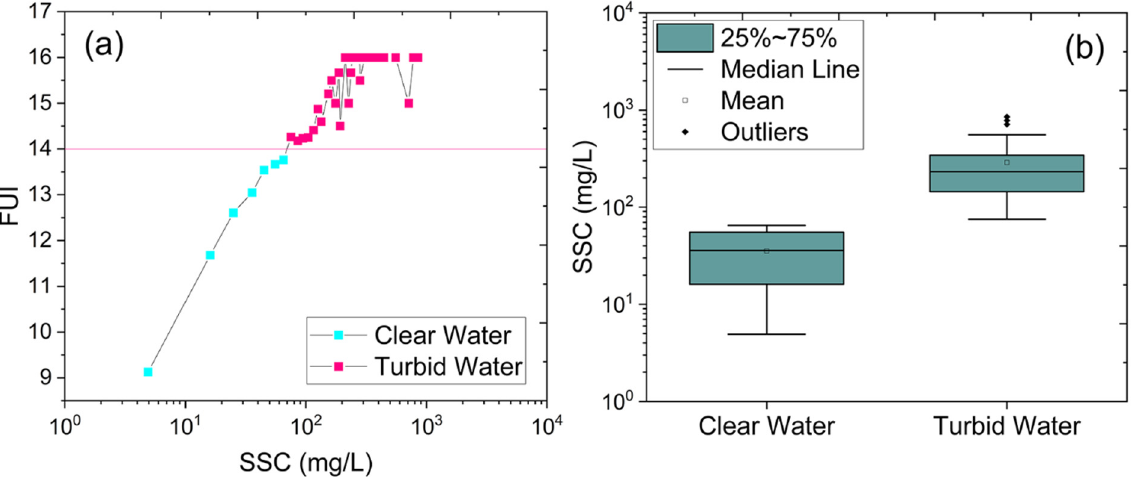
Figure 3. ( a ) Relationship between the calculated FUI and in situ SSC; ( b ) boxplots of SSC from the in situ dataset versus different optical water